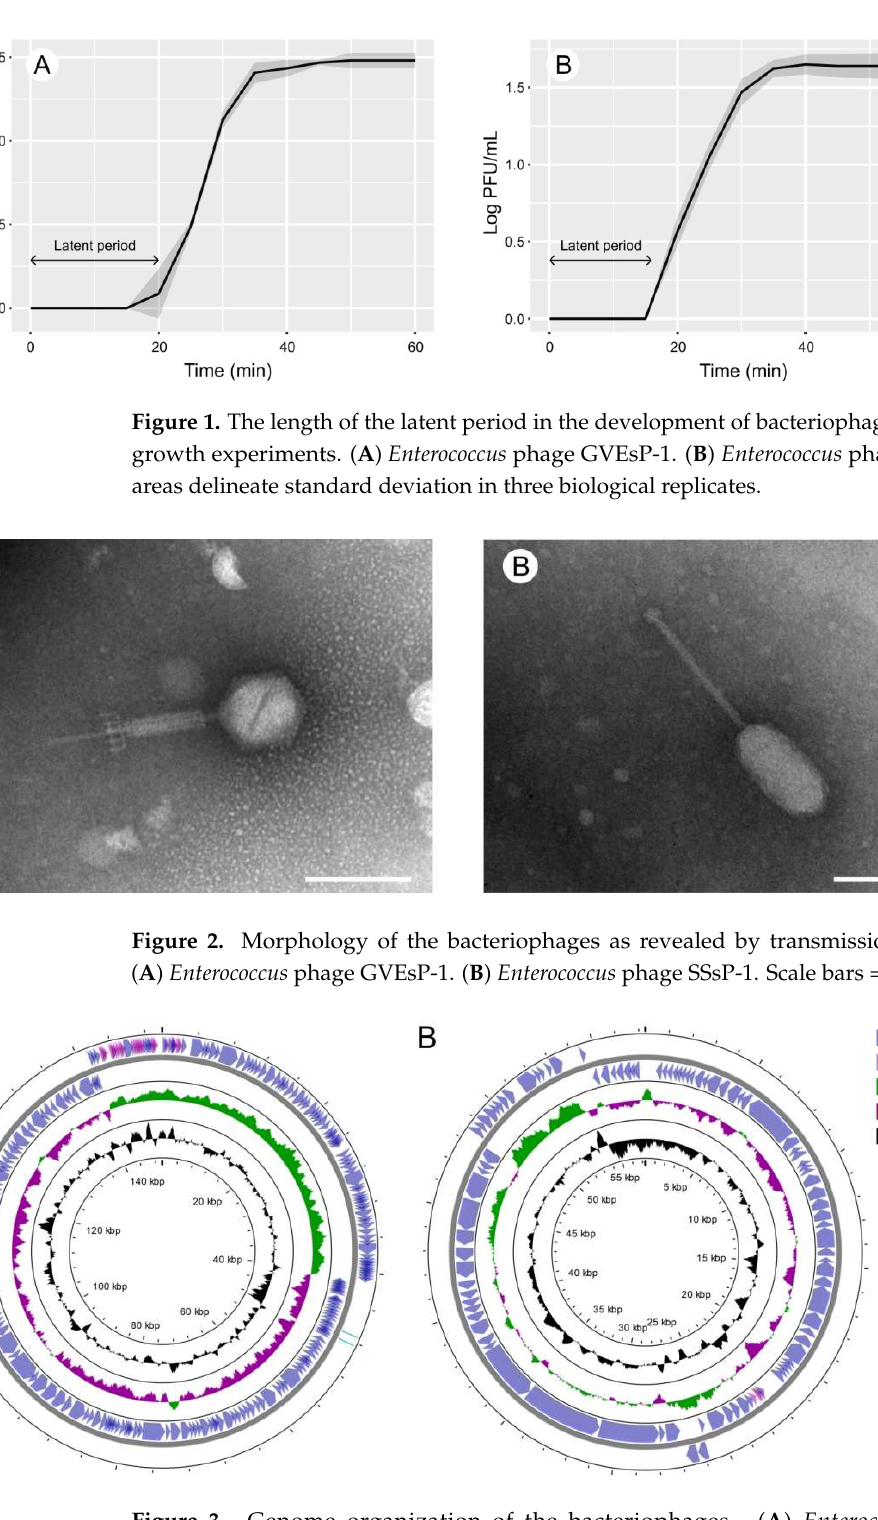
Figure 3. Genome organization of the bacteriophages. ( A ) Enterococcus phage GVEsP-1. ( B ) Enterococcus phage SSsP-1.